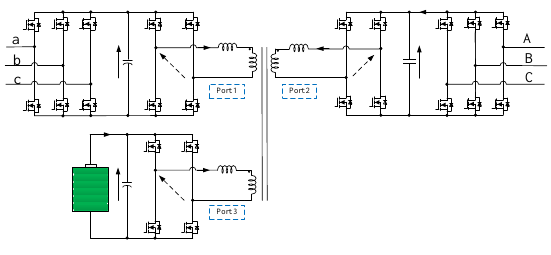
Figure 14. TAB converter in UPS